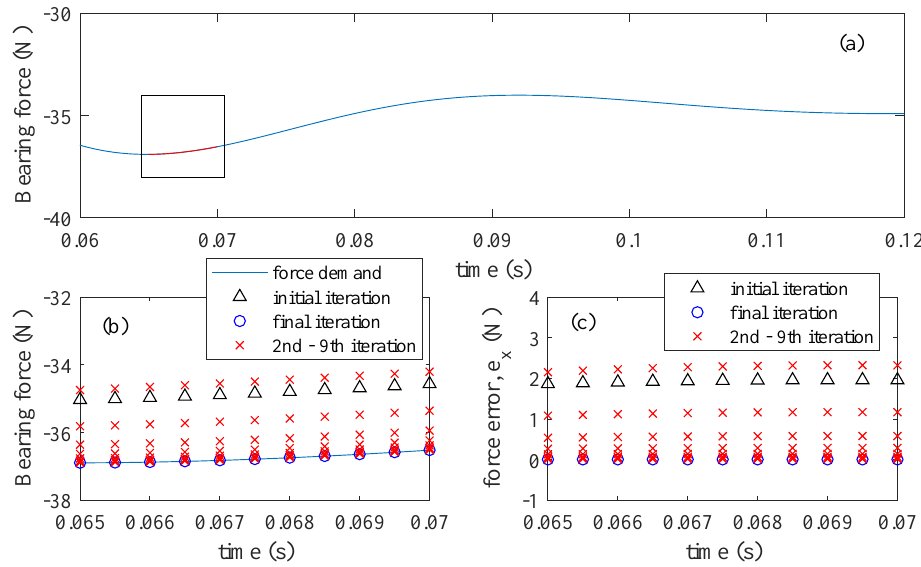
Figure 9. Bearing force computation (for F x ) with gradient-based root finding algorithm ( a ) Bearing force between 0.06 to 0.12 second ( b ) Bearing force solution updates at each time step ( c ) Bearing force error updates at each time